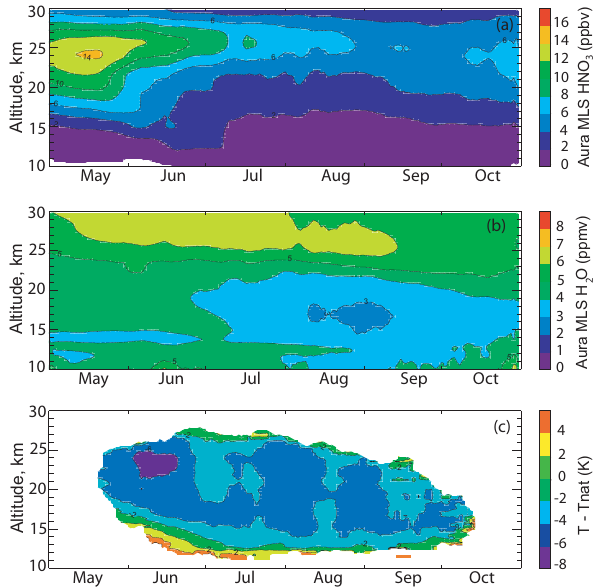
Fig. 14. Time series of three-year mean Aura MLS (a) HNO 3 and (b) H 2 O mixing ratio observations in PSC-free regions of the Antarctic vortex. The corresponding vortex-averaged differences ( 1T ) between ambient temperature at CALIPSO PSC locations and T NAT calculated using the cloud-free MLS HNO 3 and H 2 O data are shown in panel (c)